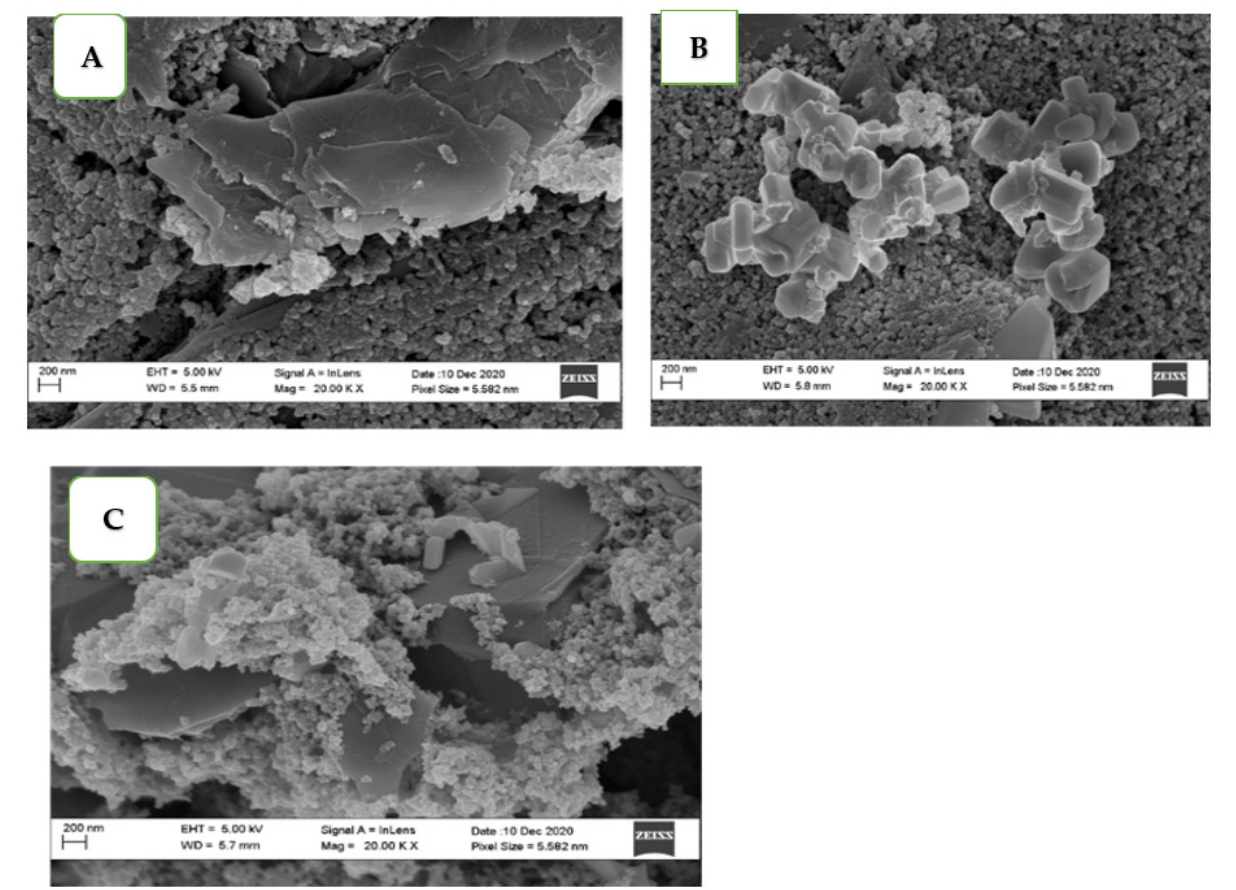
Figure 8. SEM micrographs of a Schiff base ligand polymer ( A ), Cu complex polymer ( B ), and Ni complex polymer ( C ) on the screen print carbon electrode.